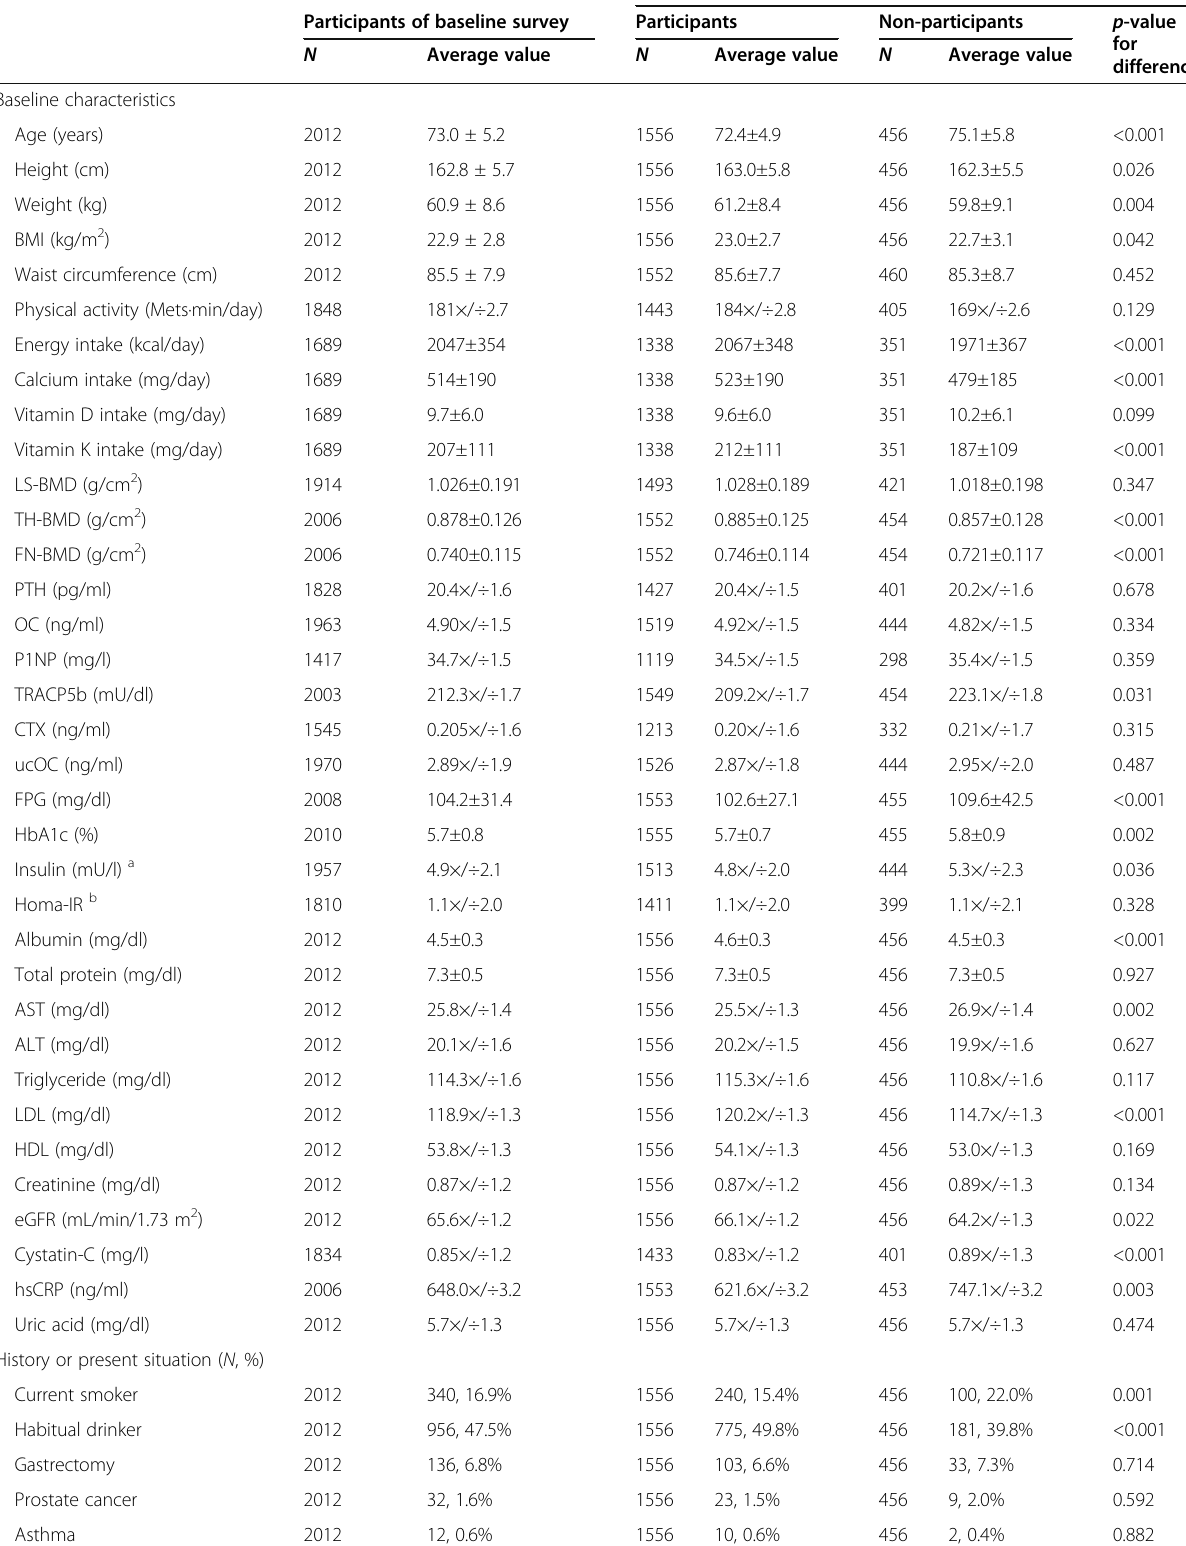
Table 2 Comparison of baseline characteristics between participants and non-participants of clinical follow-up